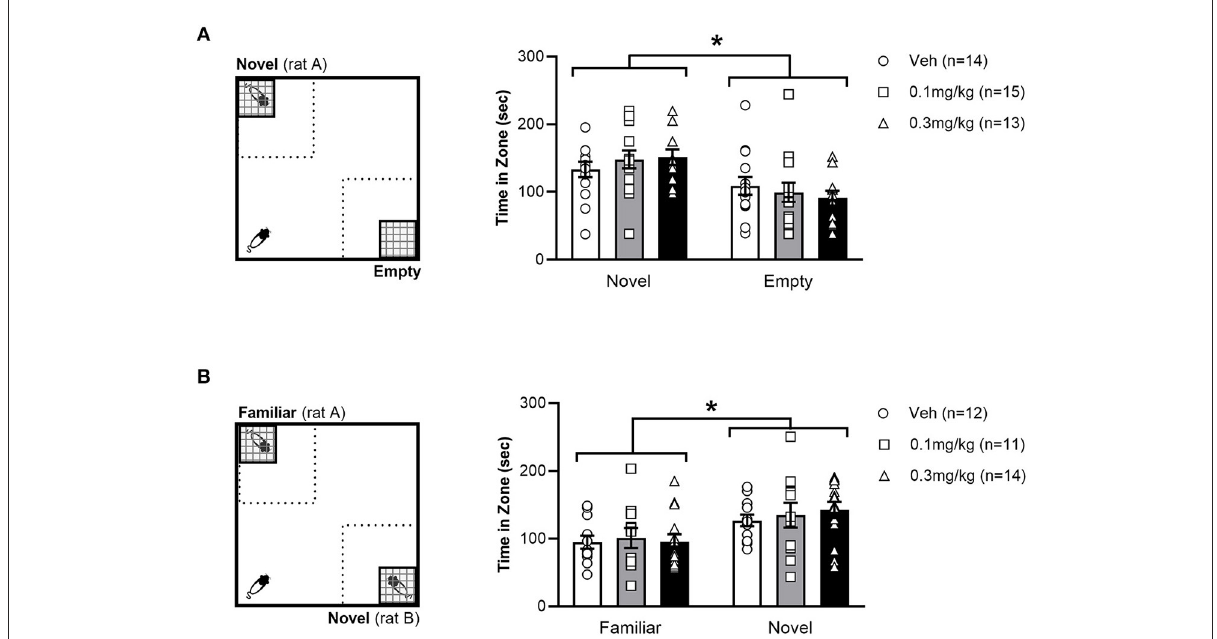
FIGURE2 Left: Experimental set up of Social Preference test (A) and Social Novelty Test (SNT) (B) . The dotted square represents the 40x40cm interaction zones. Right: Average time ( + /- SEM) spent exploring the stimulus zones during the social preference test (A) and SNT (B) in LH rats treated with vehicle (white bar), 0.1 mg/kg URB597 (gray bar) and 0.3 mg/kg URB597 (black bar), with individual values displayed as circles, squares and triangles, respectively. (A) . All treatment groups preferred the social stimulus (novel rat) to the non-social stimulus (empty cage), while